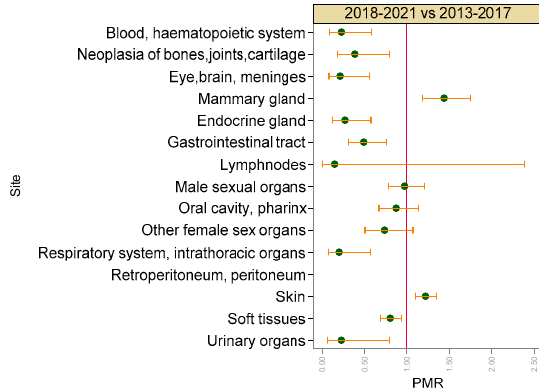
Figure A5. Proportional morbidity ratios (PMR) of benign tumours by topography comparing benign tumours diagnosed in the last years of activity (2018–2021) with the first period of activity (2013–2017). Dots: age-class-adjusted PMR, bars: lower and upper bound of 95% confidence interval. A vertical reference line indicates PMR = 1.